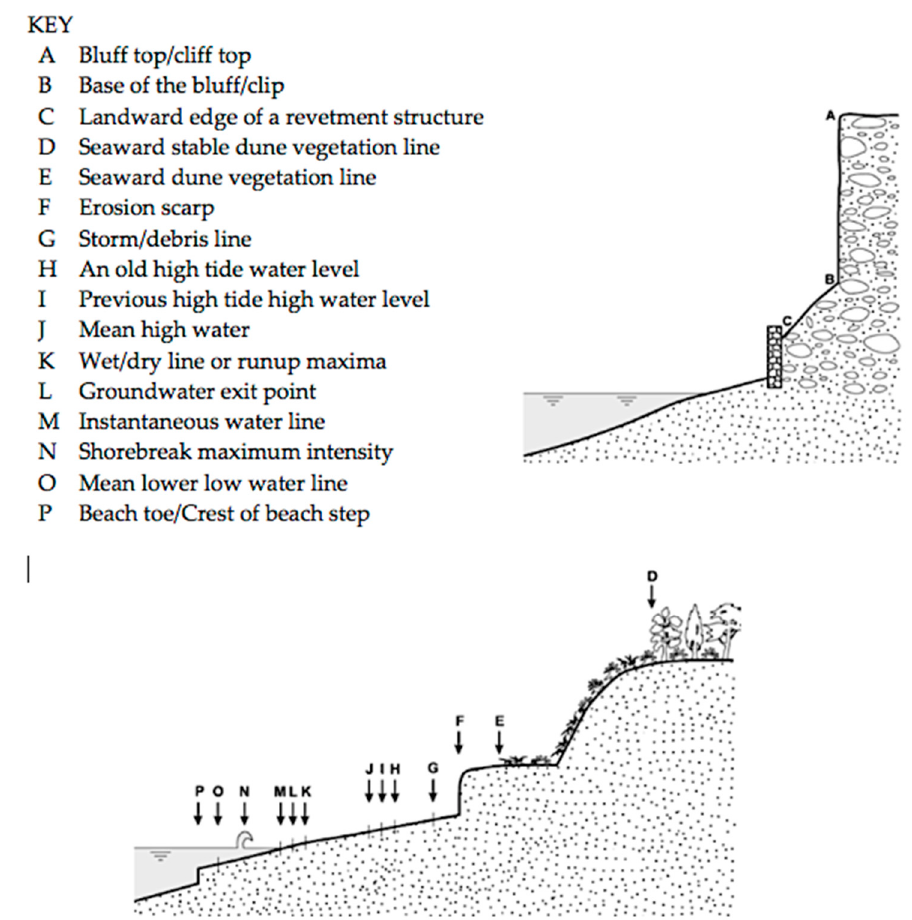
Figure 2. Sketch of the spatial relationship between many of the commonly used shoreline indicator [8]. Table 1. Summary of shoreline indicators (adapted from [8] and [9]).